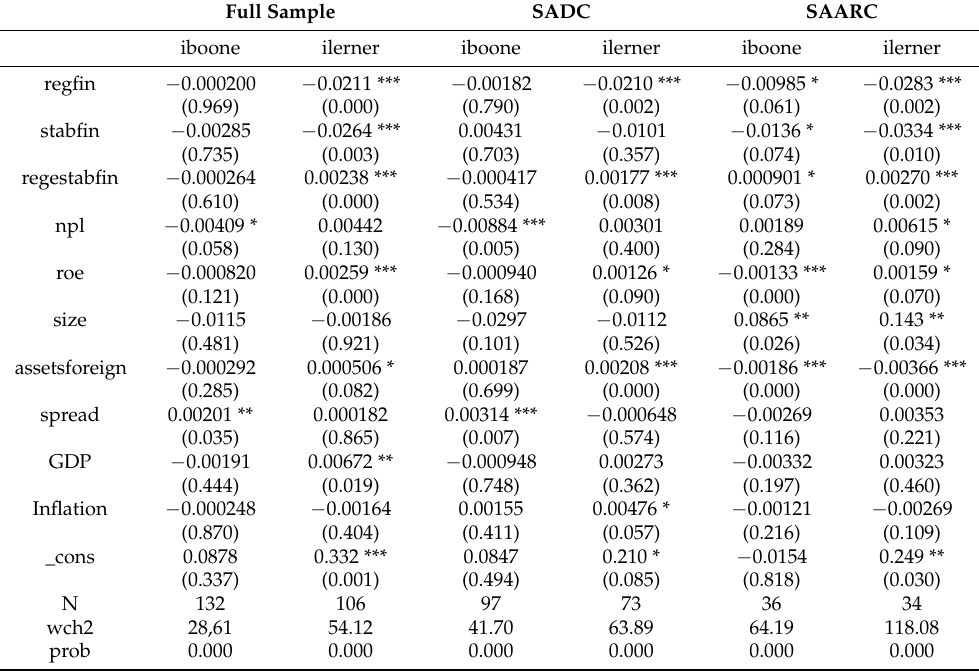
Table 9. Impact of financial regulation on